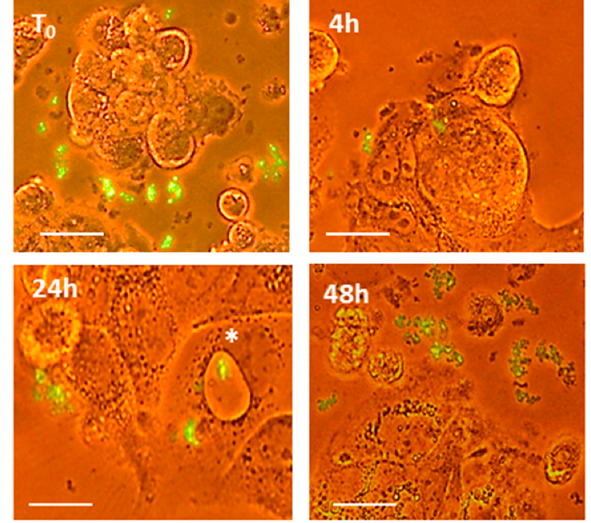
Figure 4. Internalization and extra-cellular release of fluorescent PT-gliadin in Caco-2 cells. Analysis of GLIA-488 traffic in Caco-2 cells through fluorescent inverted microscope Eclipse Nikon TS100 at T 0 – 48 h p.t. Visualizations were performed through an inverted microscope Eclipse Nikon TS100, 40× objective. Asterisk indicates a large intra-cellular vesicle containing large GLIA-488 aggregates (scale bars = 30 µm).